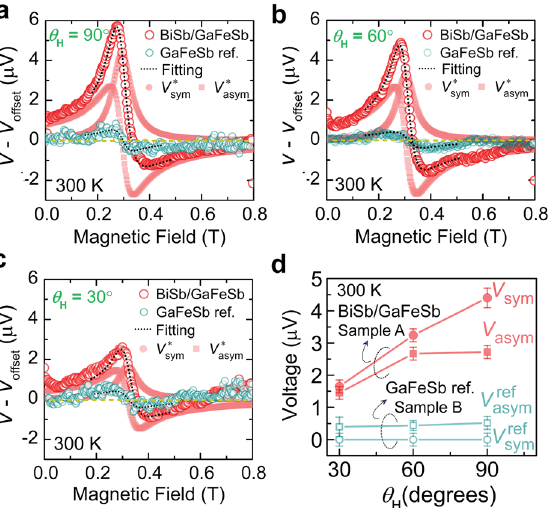
Figure 3. ( a )–( c ) Voltage signals V – V offset for the BiSb/(Ga,Fe)Sb heterostructure (sample A, red big circles) and reference (Ga,Fe)Sb sample (sample B, green small circles) observed for various magnetic field H directions ( θ H ) at 300 K, where H is in the (110) plane. The microwave power is 200 mW. Blanked circles are experimental data, and a black color dotted line is a fitting curve. Symmetric and antisymmetric component curves, obtained from the fitting, are also shown by small solid circles and squares, respectively. ( d ) The derived symmetric voltage component magnitude ( V sym ) and antisymmetric voltage component magnitude ( V asym ) of sample A (red solid symbols) and sample B (green blank symbols) at 300 K. The circles and squares represent V sym and V asym , respectively. The errors bars in ( d ) are standard deviations obtained from the fitting of the EMF